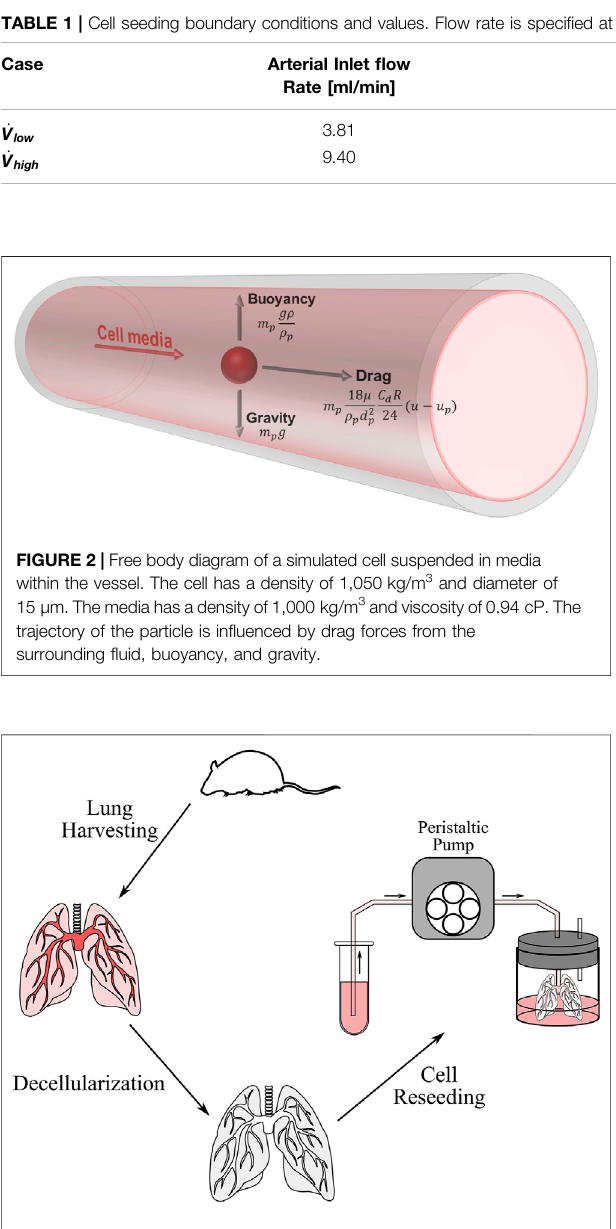
FIGURE 3 | Schematic of the decellularization and cell reseeding process. After the lung washarvested from the mouse, the lung wasperfused with decellularization solutions to remove cells and genetic content. The lung was then washed with distilled water and PBS, after which cells were reseeded through a peristaltic